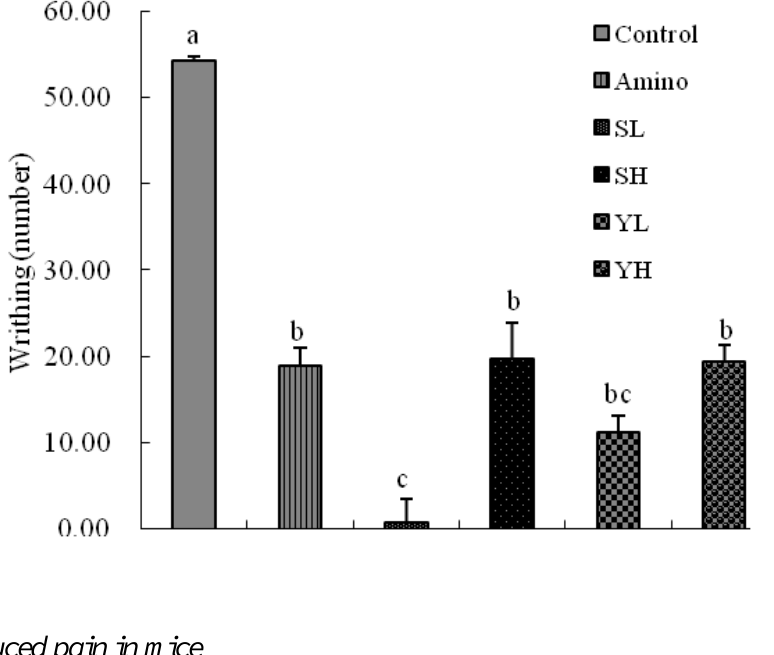
Figure 4. Effects of SoRiTae and Yak-Kong ethanolic seed extracts on acetic acid-induced writhing in mice. Amino: Aminopyrine (50 mg/kg); SL: SoRiTae (100 mg/kg); SH: SoRiTae (200 mg/kg), YL: Yak-Kong (100 mg/kg), YH: Yak-Kong (200 mg/kg). Each values was expressed as the mean ±S.E.M. (n = 6). a-c Means in the same column not sharing a common letter are significantly different (p < 0.05) by Duncan's multiple